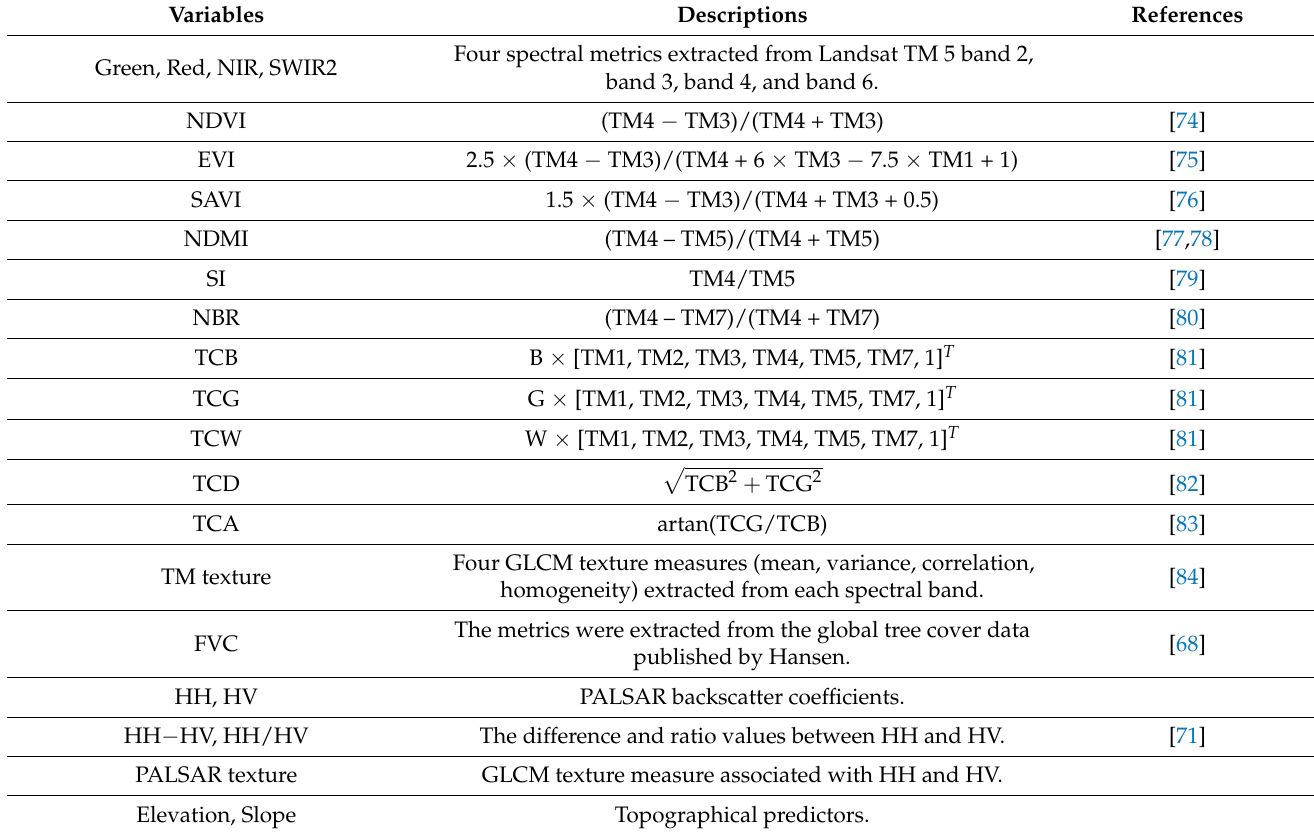
Table 1. Descriptions and equations for predictor